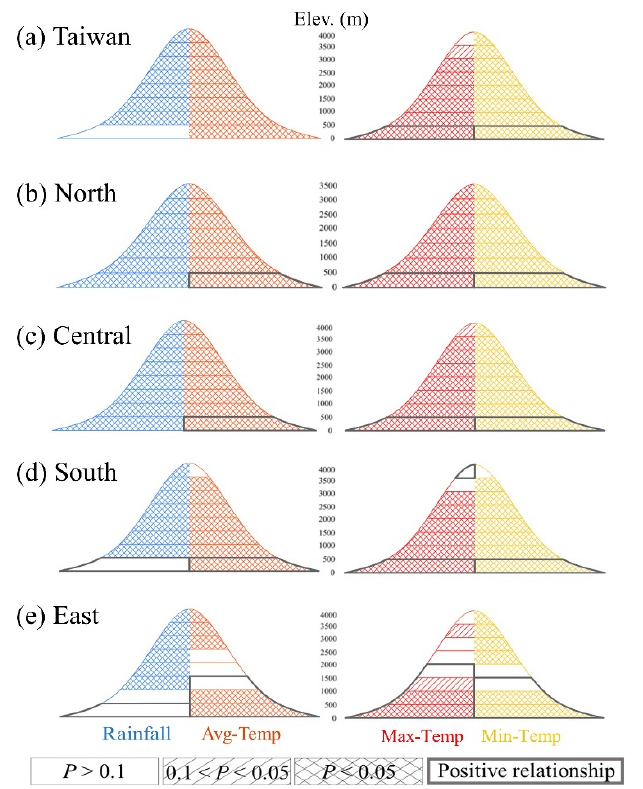
Figure 15. Regional correlations between NDVI and climatic factors at varied elevations for ( a ) Taiwan, ( b ) north, ( c ) central, ( d ) south, and ( e ) east regions.